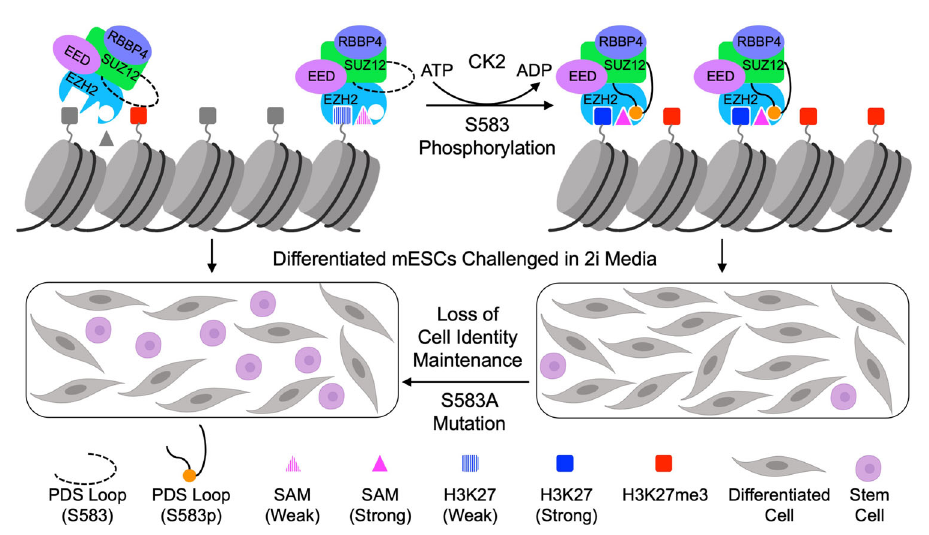
Fig. 7 | A modelofPRC2 functionpromoted by the phosphorylation ofS583 of SUZ12. Cartoons illustrate how SUZ12 phosphorylation stabilizes enzyme active site and promotes PRC2 function. S583 phosphorylation induces conformational changeofthePDSloopofSUZ12,stabilizestheSAM-bindingpocket,andconvertsa weak binding state of SAM to a strong binding state. This also facilitates histone